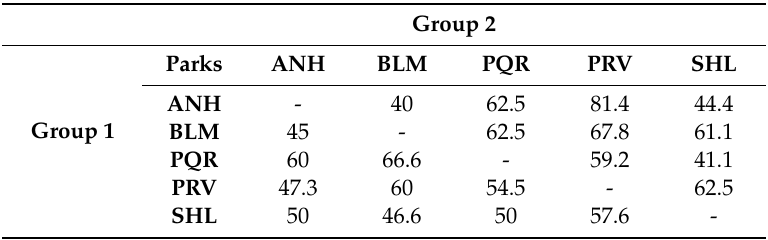
Table 5. Pairwise cross-validated classification scores (%) for Ae. albopictus populations. Group